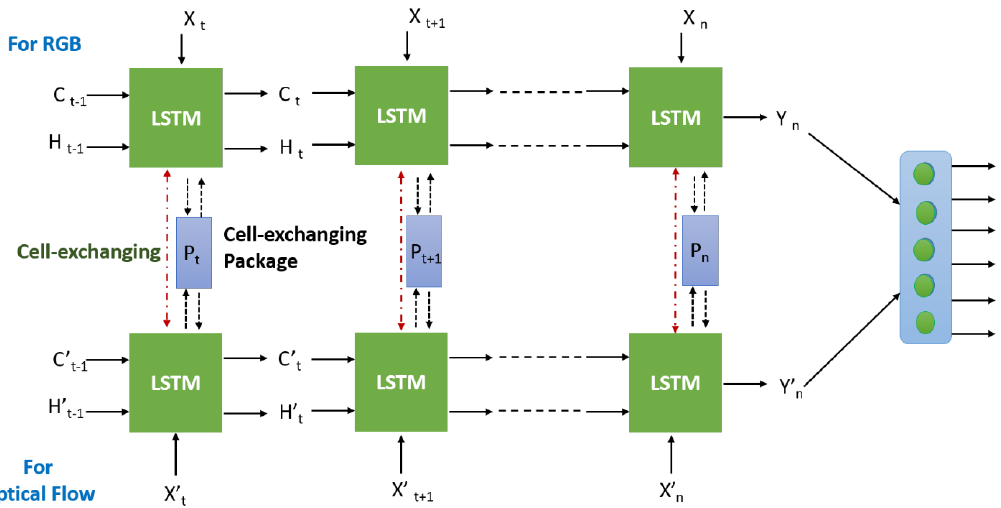
Figure 1. Proposed two-stream, RGB and optical flow-based state-exchanging in Long Short-Term Memory (SE-LSTM).